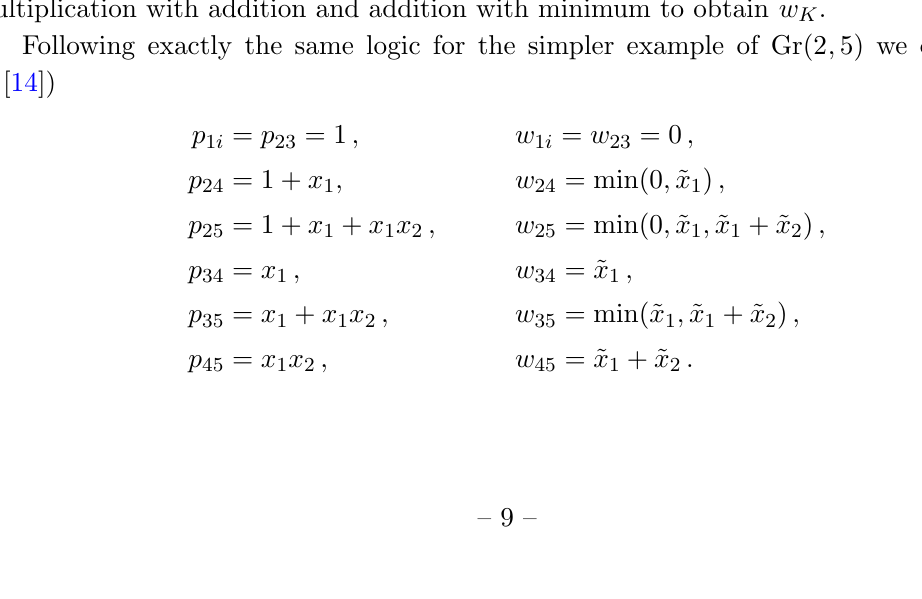
1 ; 2 to 6 ; 7 describing the representa- f g f g ([ k ] K ) to K ([ k ] K ). We denote the n \ n \